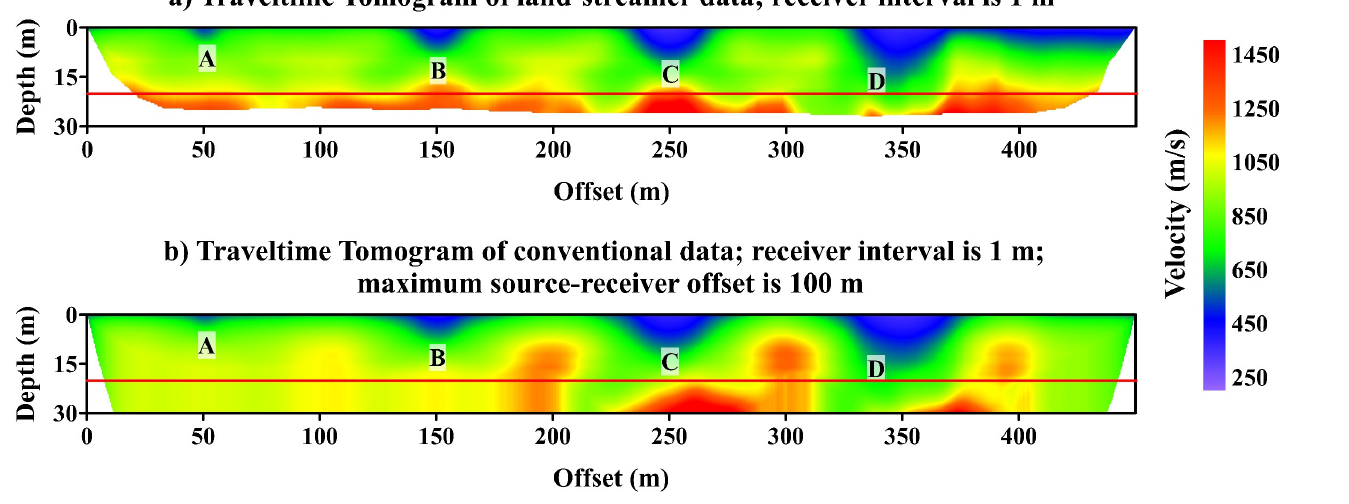
Figure 10. ( a ) The traveltime tomograms of the land-streamer synthetic example using 1 m receiver interval, it is the same tomogram shown in Figure 9b and repeated here for comparison. A, B, C, and D represents the four local anomalies added to the velocity model. ( b ) The traveltime tomogram of the conventional synthetic example using 1 m receiver interval and 100 m maximum source-receiver offset.